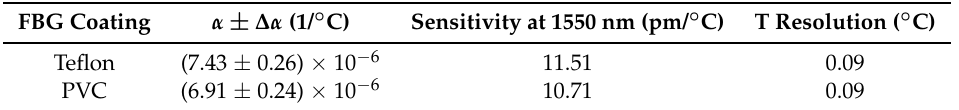
Table 1. The results of the thermal calibration: The thermal sensitivities were calculated for two types of FBG coating (packaging) material used in the